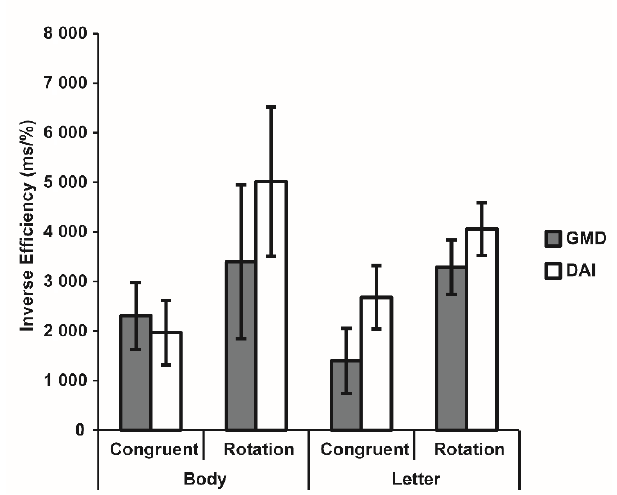
Figure 5. Inverse Effect (IE) for each condition of the Visuospatial Imagery Paradigm for the two clinical groups. Bars indicate the Standard Error of the Mean of measurements in 64 Body and 64 Letter trials for 15 participants with GMD and 16 participants with DAI.